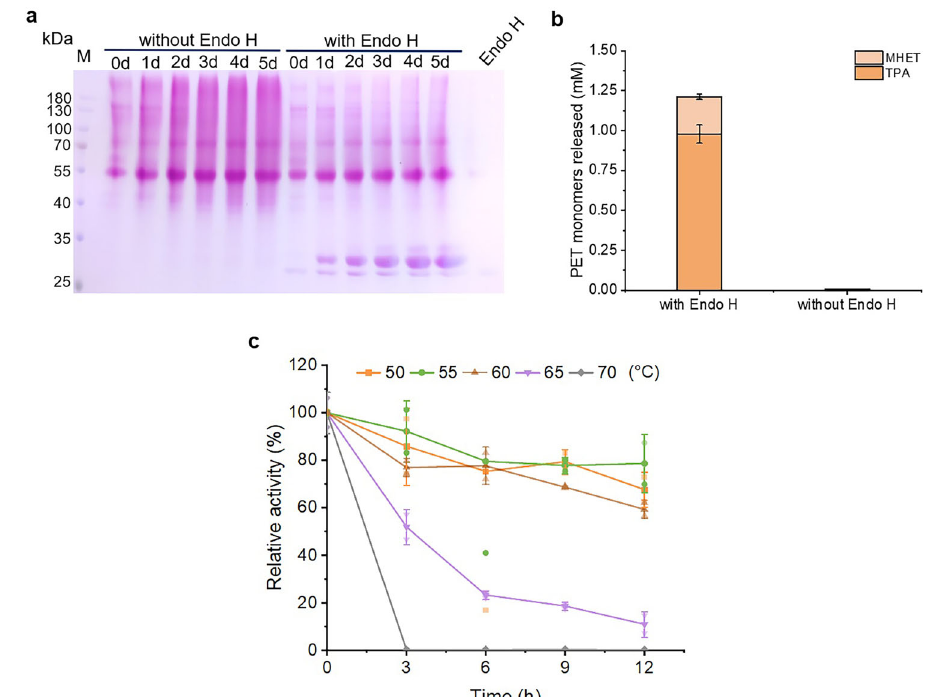
Fig. 5 Preparation of Fast-PETase- Pp with the high-density fermentation. a Glycoprotein staining to analyze the expression of Fast-PETase during the high-density fermentation. The supernatant of the cell culture was collected every 24 h and treated with Endo H for half an hour at 30 °C. b The activity of Fast-PETase- Pp before and after Endo H treatment. c The thermostability of partial-deglyco Fast-PETase- Pp . The activity of the enzyme without treatment was set to 100%. Data are presented as mean ± SD.